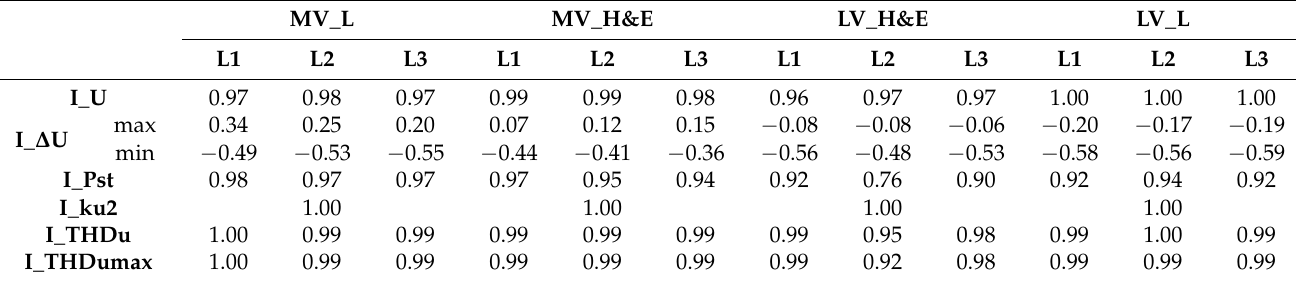
Table 2. Correlation between global indicators and PQ parameters using Pearson